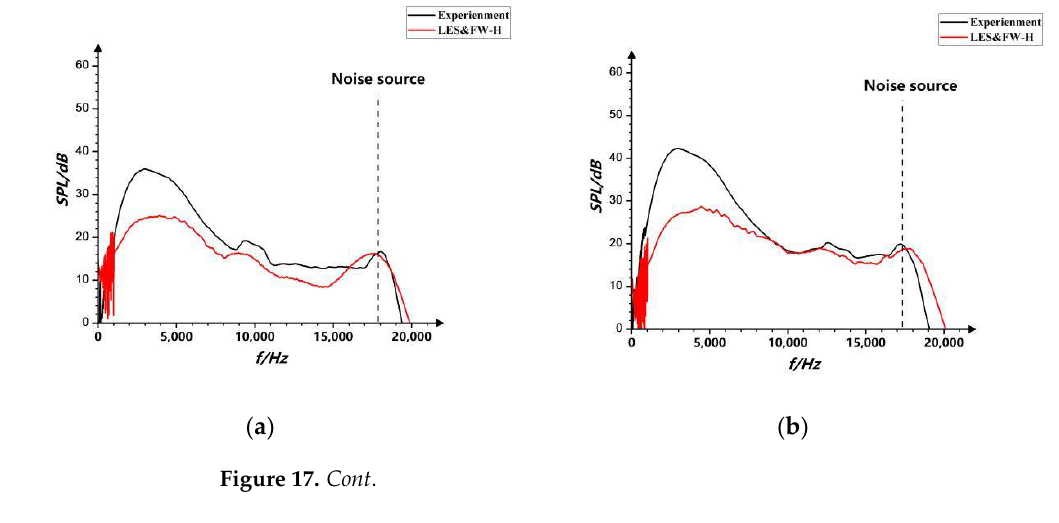
Figure 16. The wind angle 0°. ( a ) Wind speed 25 m/s; ( b ) Wind speed 30 m/s; ( c ) Wind speed 35 m/s; ( d ) Wind speed 40 m/s.